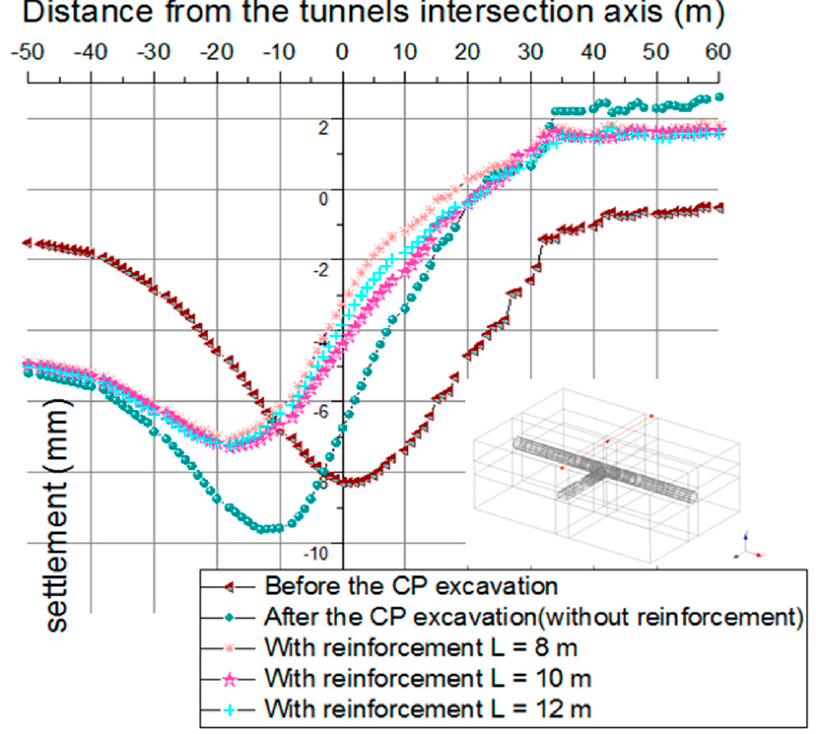
Figure 5. Effect of the umbrella arch technique on the transverse settlement trough.